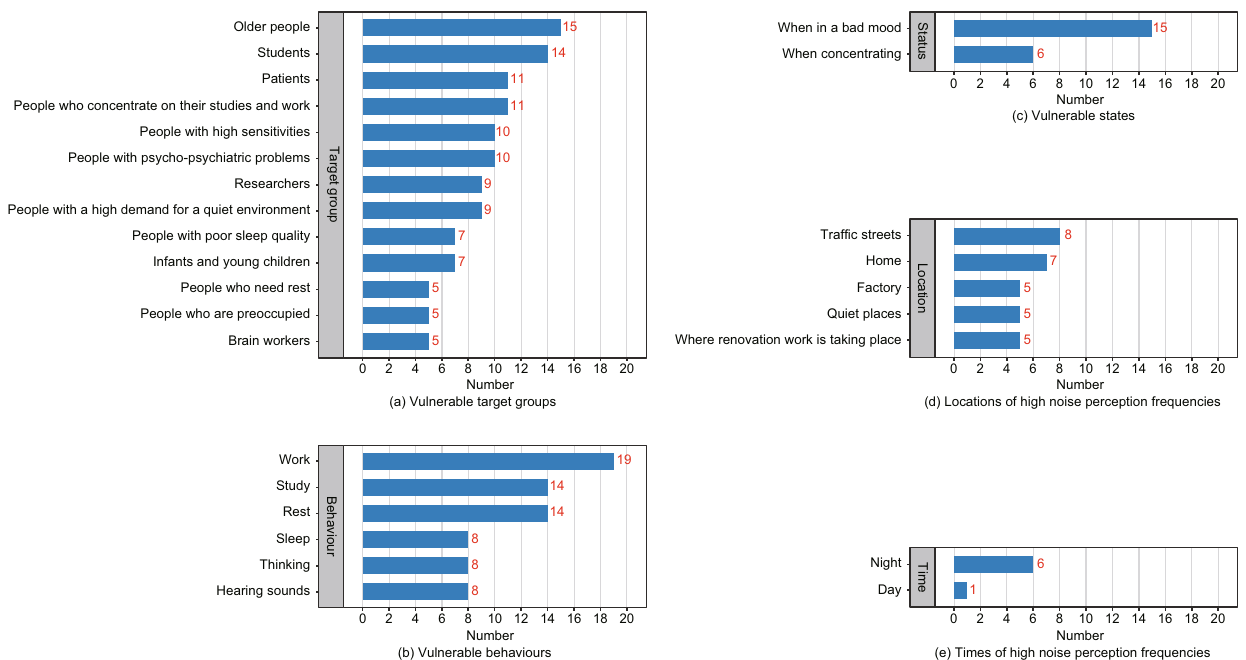
Fig. 5 Quanti fi cation of word frequency statistics. a Vulnerable target groups, b Vulnerable behaviors, c Vulnerable states, d Locations of high noise perception frequencies, and e Times of high noise perception frequencies.